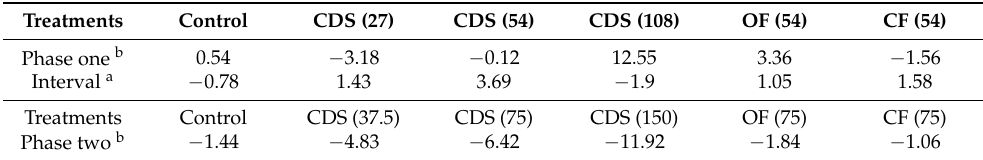
Table 9. Soil AP loss of the treatments in phase one and two